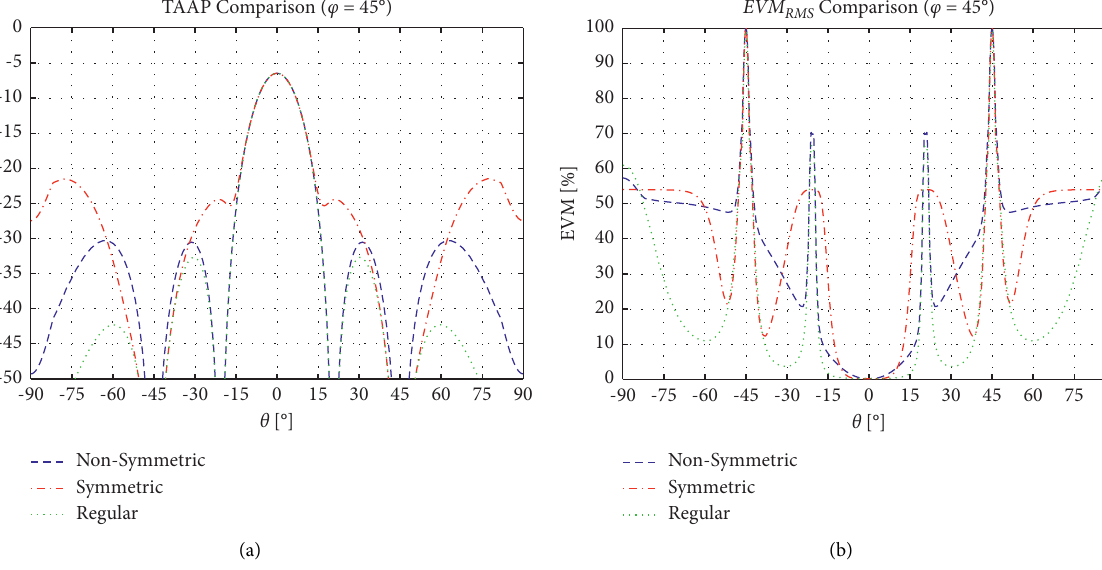
Figure 6: TAAP and EVM performance comparison between the regular array and the outspacing symmetric and nonsymmetric /2, C / N � 50 dB , transmitted signal is QAM16, and a cos θ element power configuration at the cross section: φ � 45 ° , K � L � 8, d x � d y � λ 0 pattern is used. (a) Time average array pattern. (b)